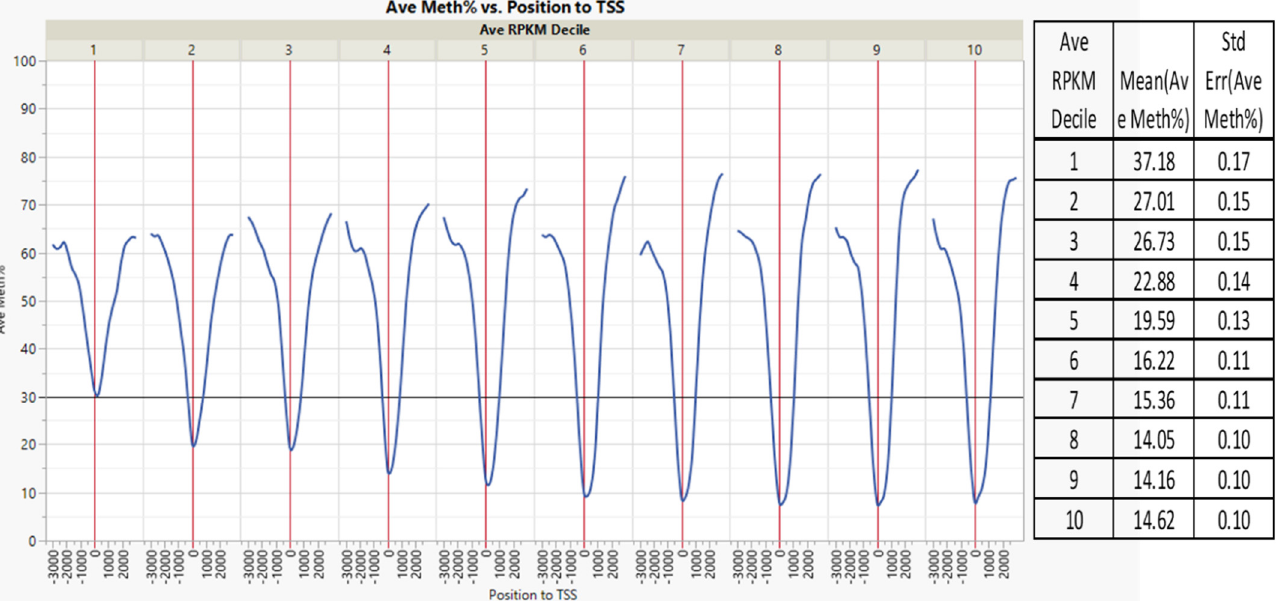
Figure 3. Inverse weak/moderate correlation between gene expression decile and DNA methylation within ±1 kb flanking TSS and positive correlation within the gene body’s +3 to +10 kb region.